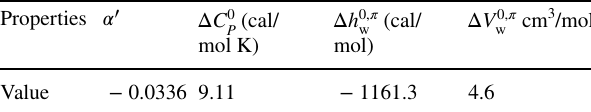
Table 1 Langmuir constant (coefficients of correlation for CH hydrates)